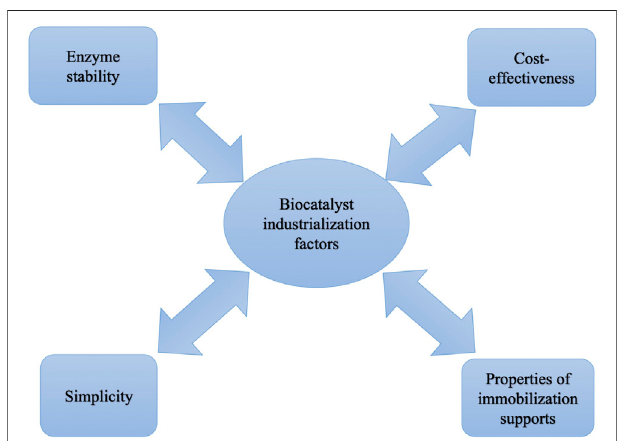
FIGURE3| Importantfactorstobeconsideredinbiocatalystdesignand